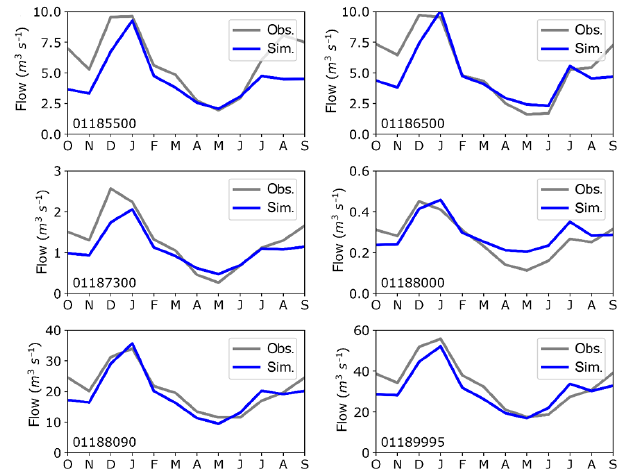
Figure 4. Time series comparing simulated and observed monthly- averaged stream flows at selected USGS gages in the Farmington River basin. Table 6. Stream temperature metrics ( ◦ C) for classifying streams in Connecticut into thermal classes (after Table 3 of Beauchene et al.,